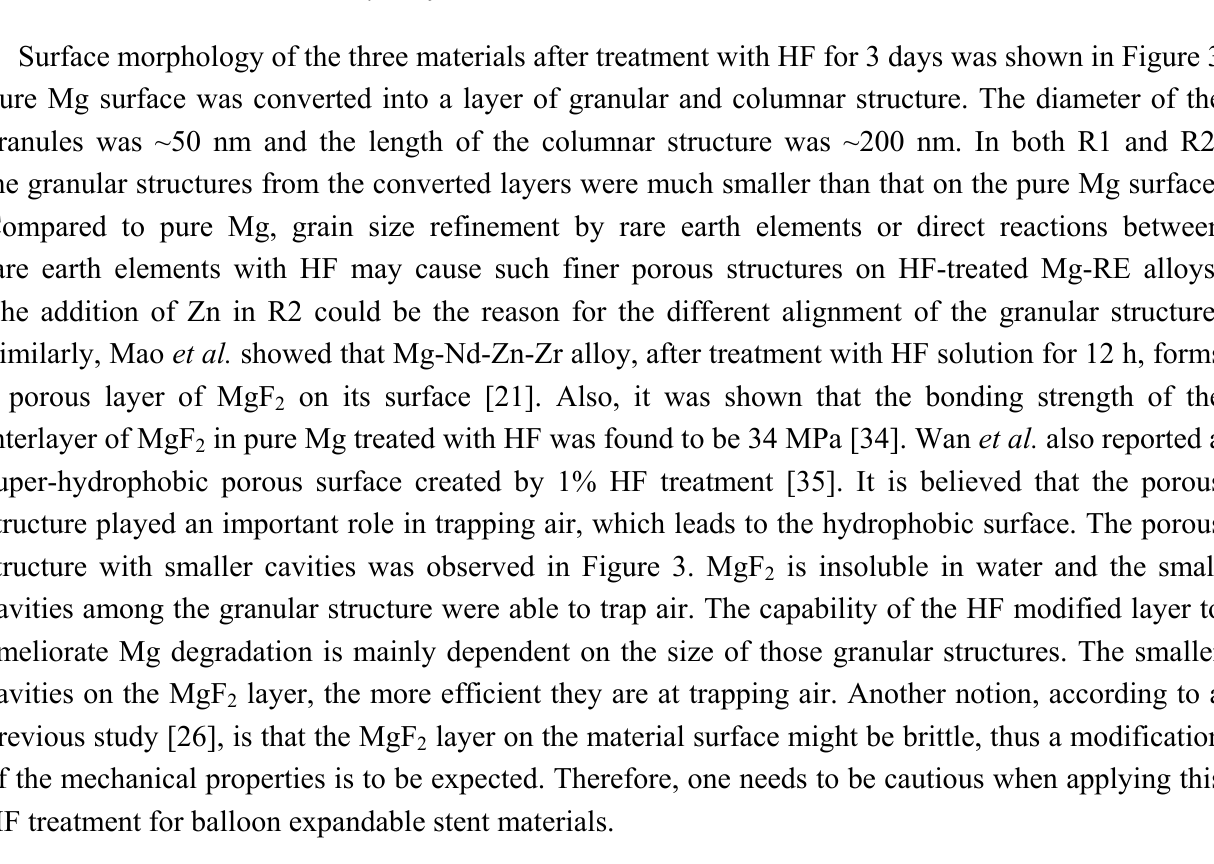
Figure 3. SEM images of fluoride coating morphologies. All the materials were treated with HF solution for 3